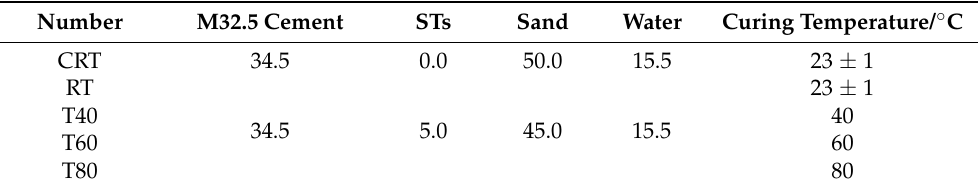
Table 3. The mix proportion of mortars for investigating the effect of curing temperature on the properties of mortars (g/100